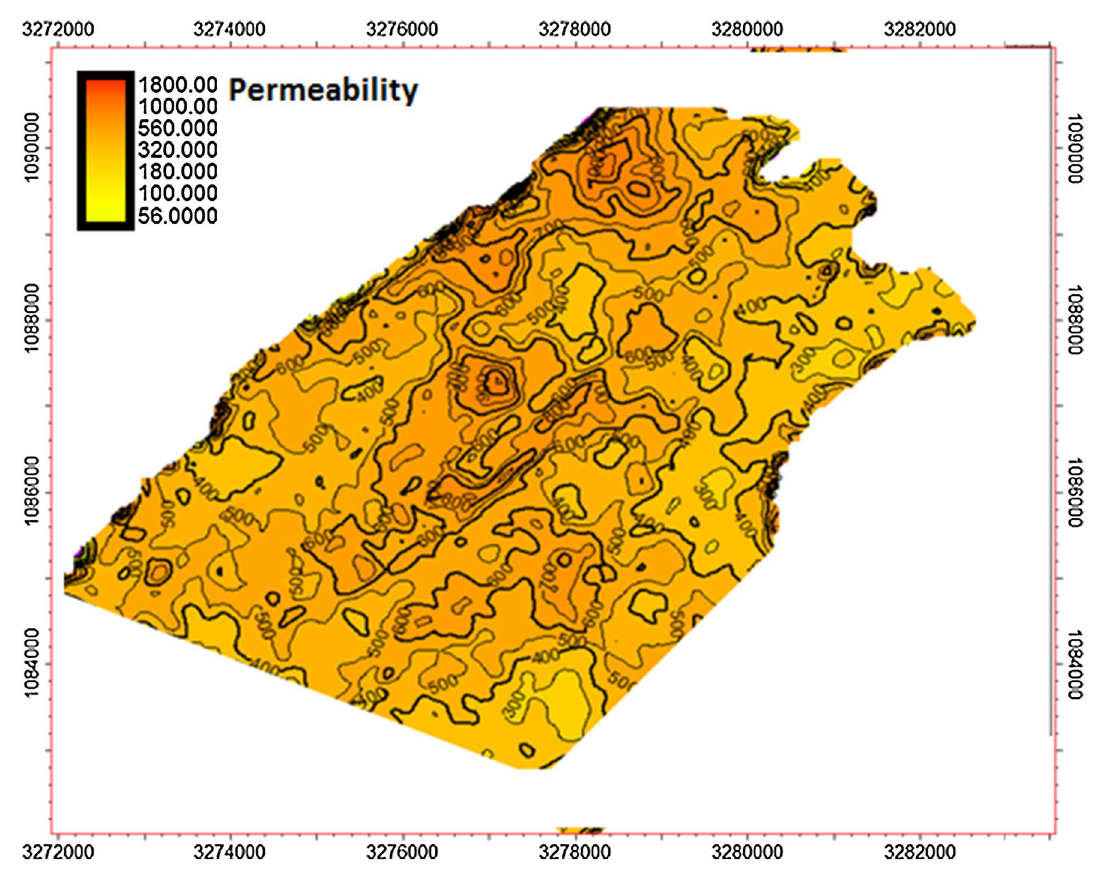
Fig. 3 Permeability